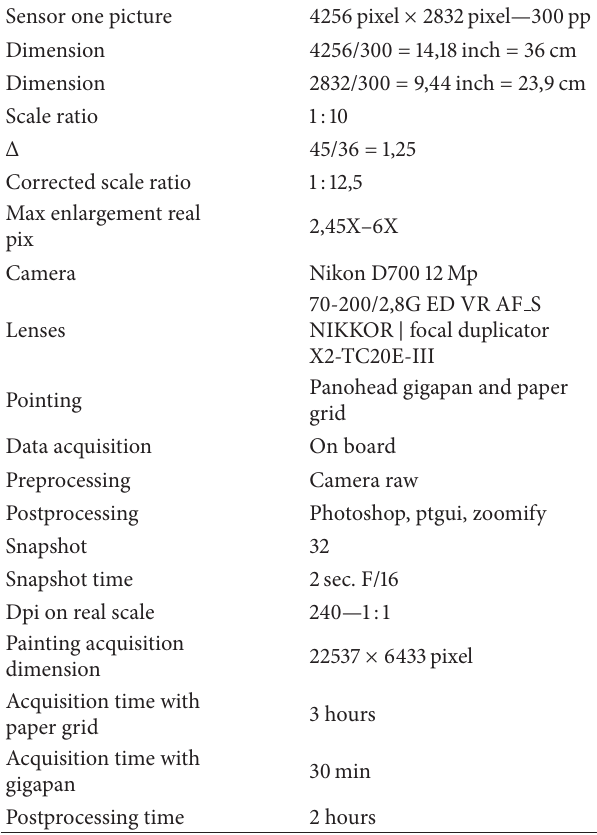
Table 1: Acquisition results